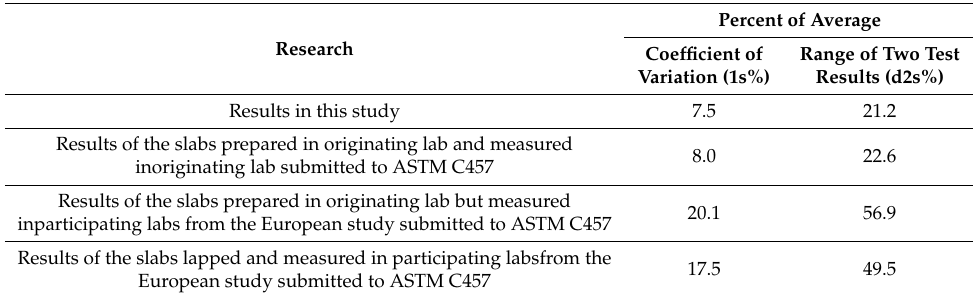
Table 5. Average precision data of the voids spacing obtained in this study compared with the European study submitted to ASTM C457 [8].